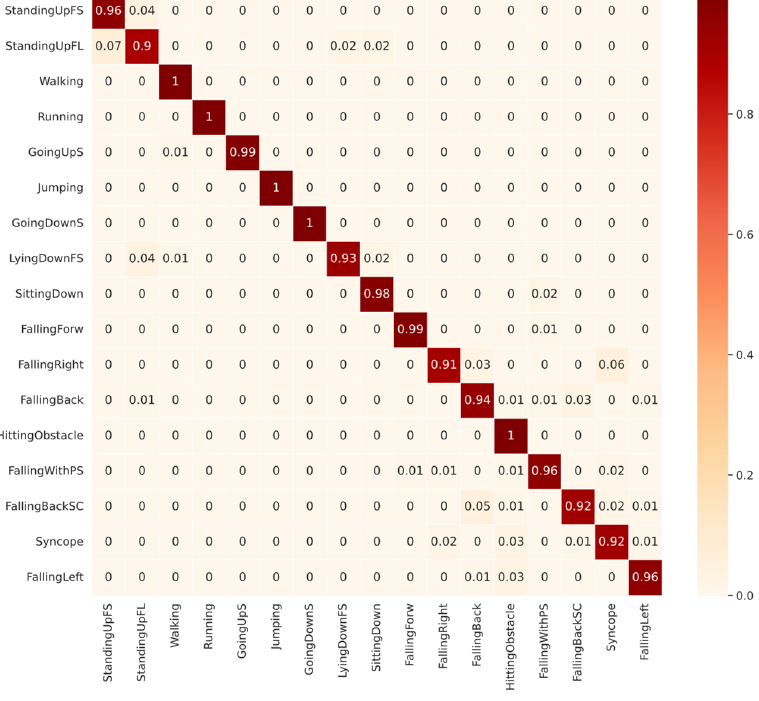
Figure 6. Confusion Matrix of CNN1 with subject-dependent 70/30 for all 17 classes of UniMiB- SHAR dataset.